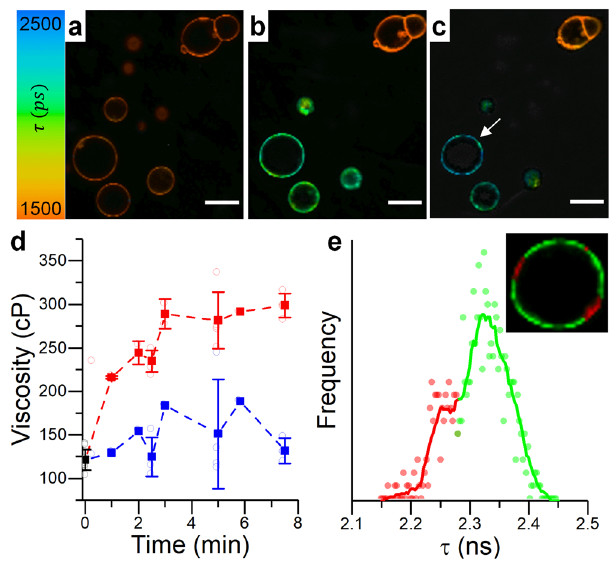
Fig. 3 Type II photo-oxidation of POPC GUVs, monitored by FLIM of BC10. a – c FLIM images recorded at 0 s, 150 s and 450 s. Only the bottom left section was irradiated. Scalebar: 20 µ m. d Changes in microviscosity recorded for irradiated (red) and non-irradiated (blue) GUVs. Data shown as mean ± S.D ( N ≥ 3 GUVs in n = 3 independent repeats). e Lifetime distribution histogram and a zoomed in FLIM image of the irradiated GUV indicated by the white arrow in ( c ). Discrete color-coding of the inset FLIM image has been used to highlight areas of different